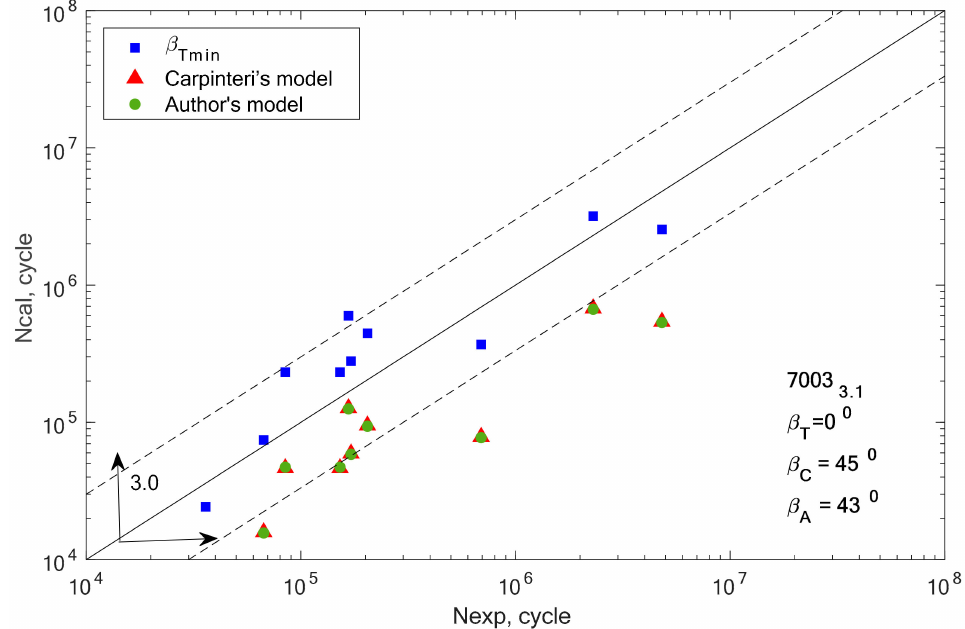
Figure 11. Comparison of the obtained design and experimental life for aluminium alloy 7003-3.1 for the cyclic bending–torsion